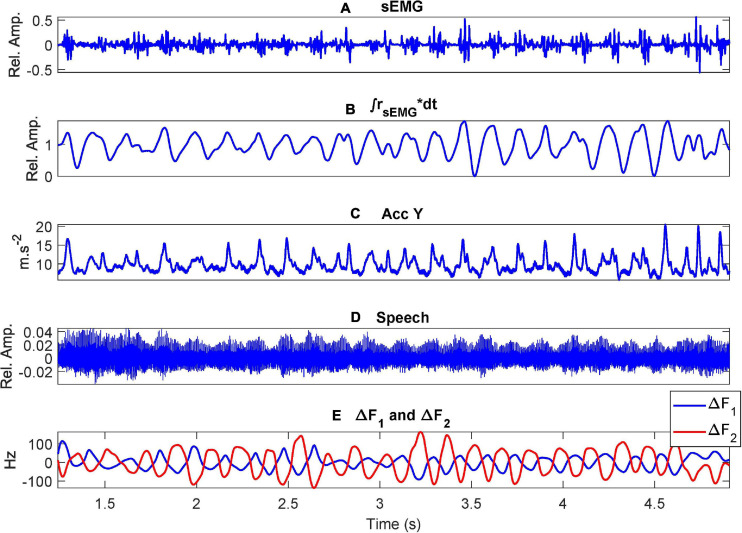
Example recordings when uttering the repetition of […aI…] by a control participant (CMa): (A) the sEMG on the masseter muscle; (B) the ECMF; (C) acceleration on the vertical axis (sagittal plane); (D) speech signal; (E) first two formant oscillations (unbiased). Where (*) stands for the multiplication operation.